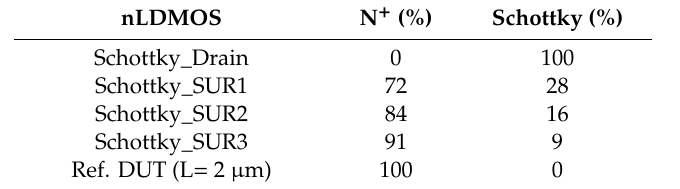
Table 1. Area ratios of N + and Schottky diode regions in the drain electrode.